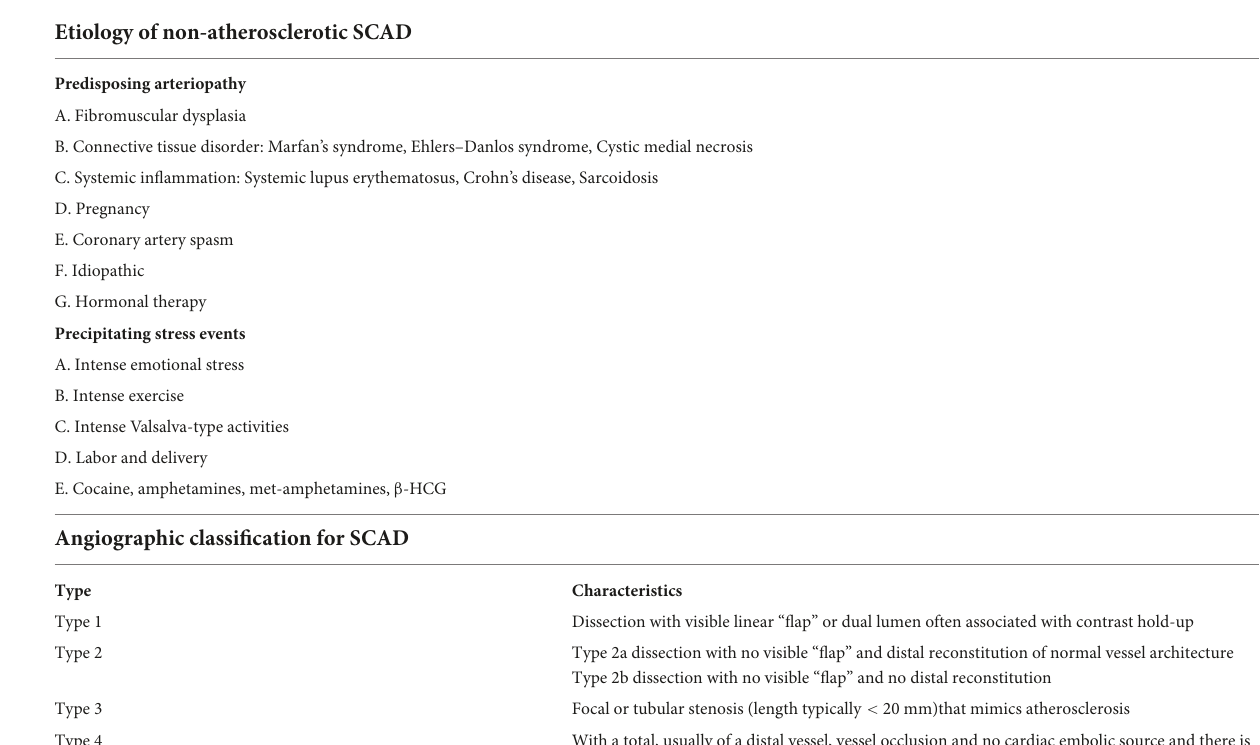
TABLE 1 Spontaneous coronary artery dissection